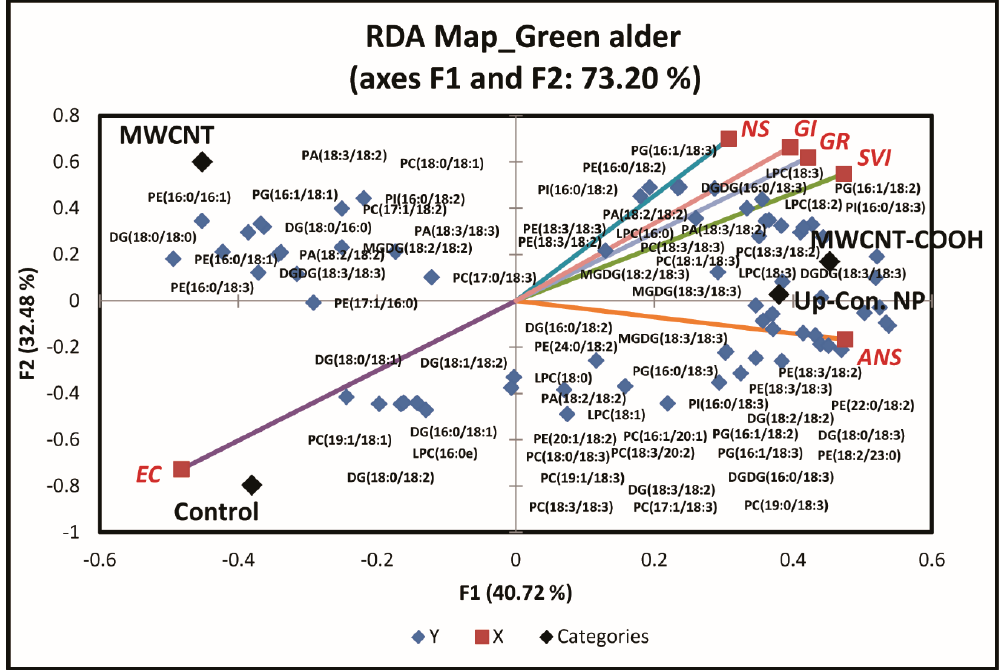
Figure 7. First redundancy analysis (RDA) of green alder showing the groupings of membrane lipids with seed physiological parameters following seed priming with CNP, where n = 100 plants for each treatment. MWCNT–COOH = multiwall carbon nanotubes functionalized with carboxylic acid, MWCNT = multiwall carbon nanotubes, up-con = up conversion nanophosphors. SVI = seedling vigor index, EC = electrical conductivity, GR = germination rate, NS = normal seedlings, ANS = abnormal seedlings.